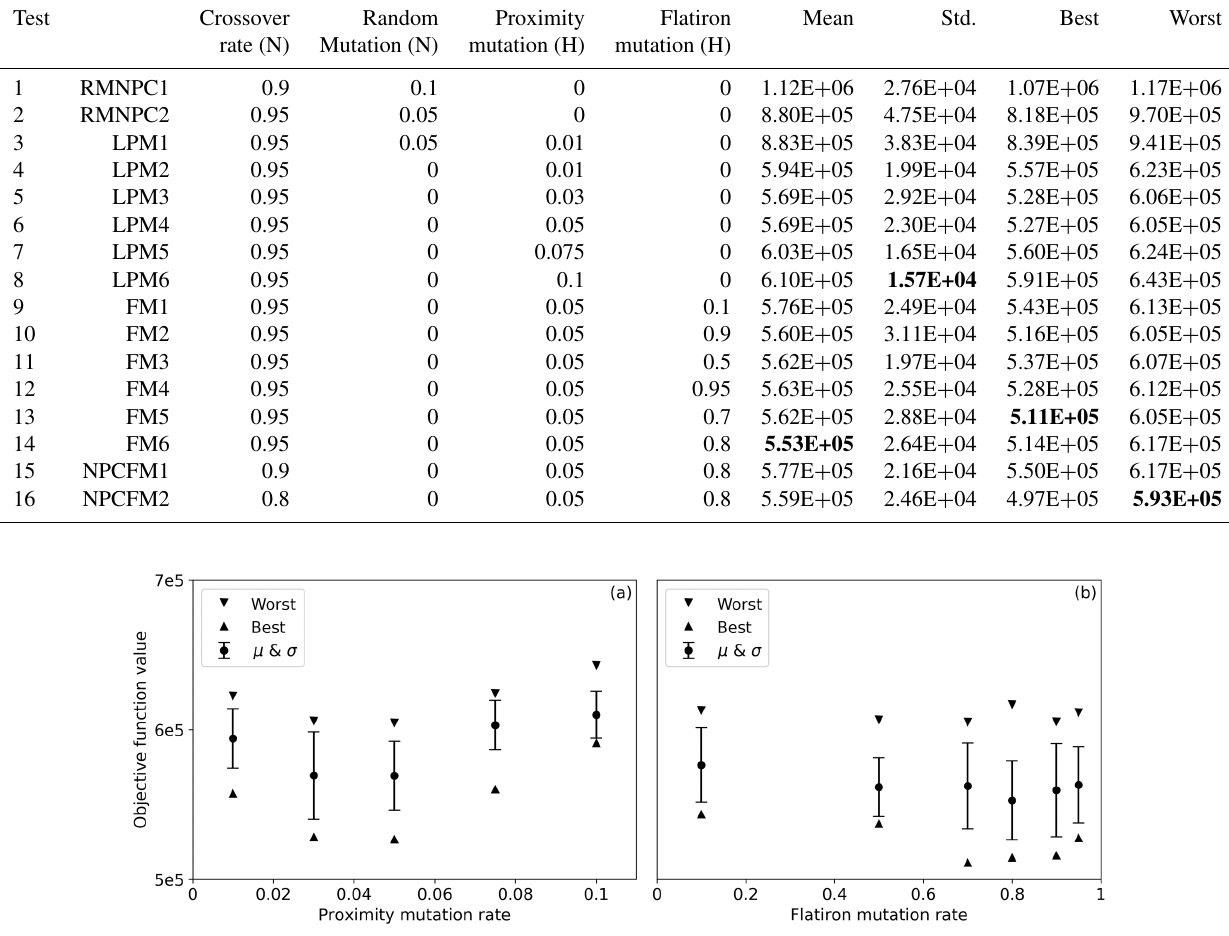
Figure 3. (a) Influence of the proximity mutation rate on the obtained objective function values in tests LPM2, LPM3, LPM4, LPM5 and LPM6. (b) Influence of the flatiron mutation rate on the obtained objective function values in tests FM1, FM2, FM3, FM4, FM5 and